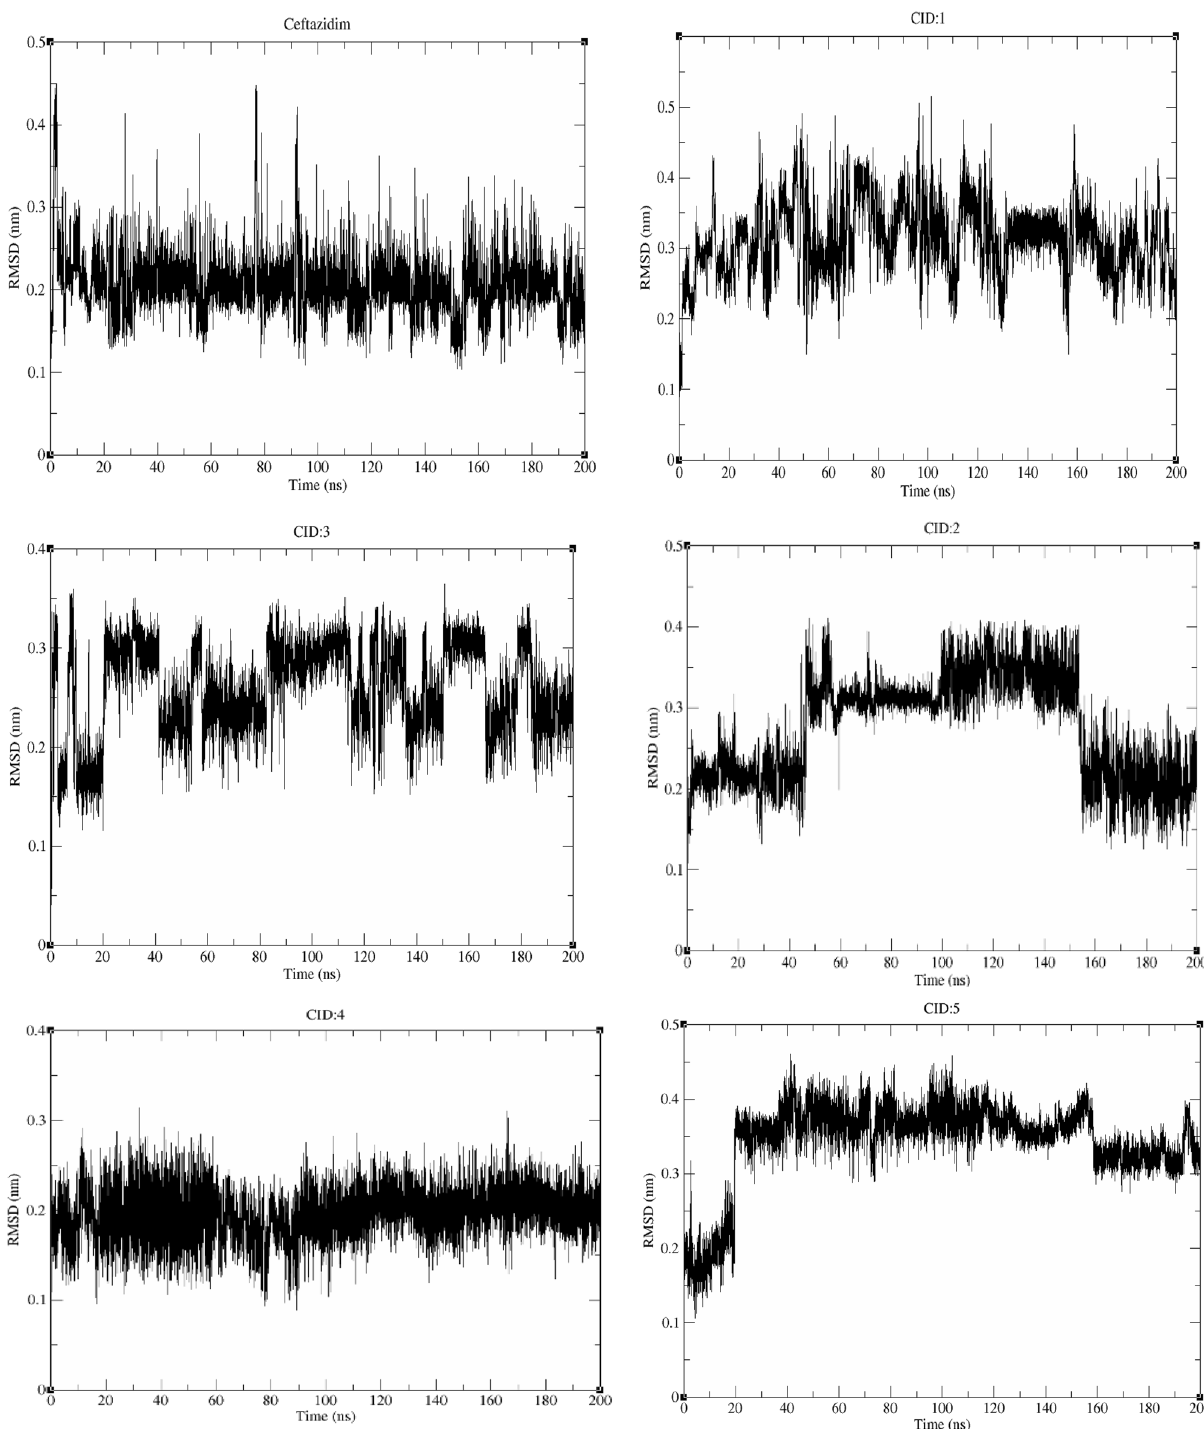
Figure 4. Root mean square deviations (RMSDs) of the ligand–protein complexes generated during the MD